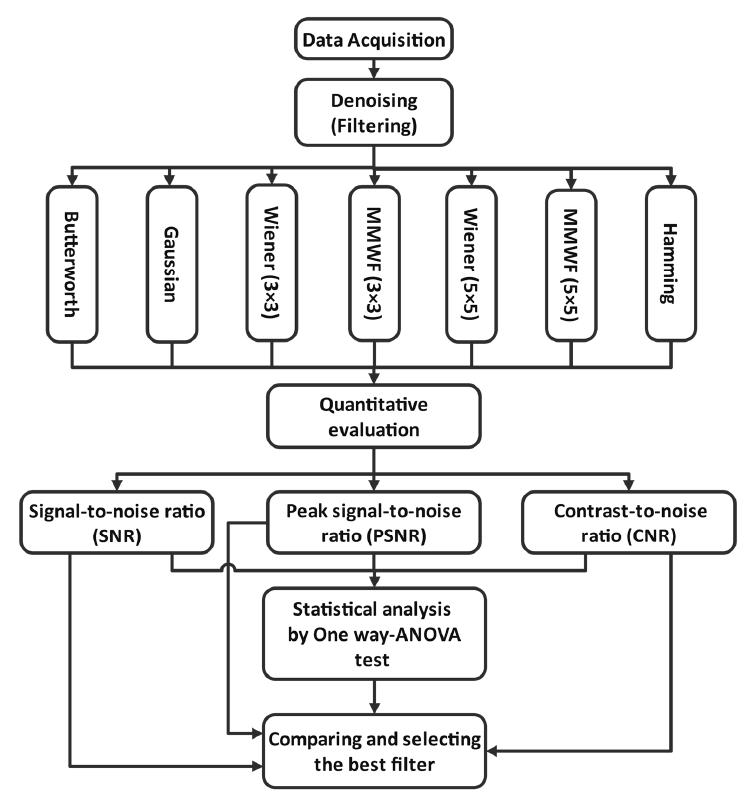
Figure 1. Steps followed in this study (x × x represents the kernel